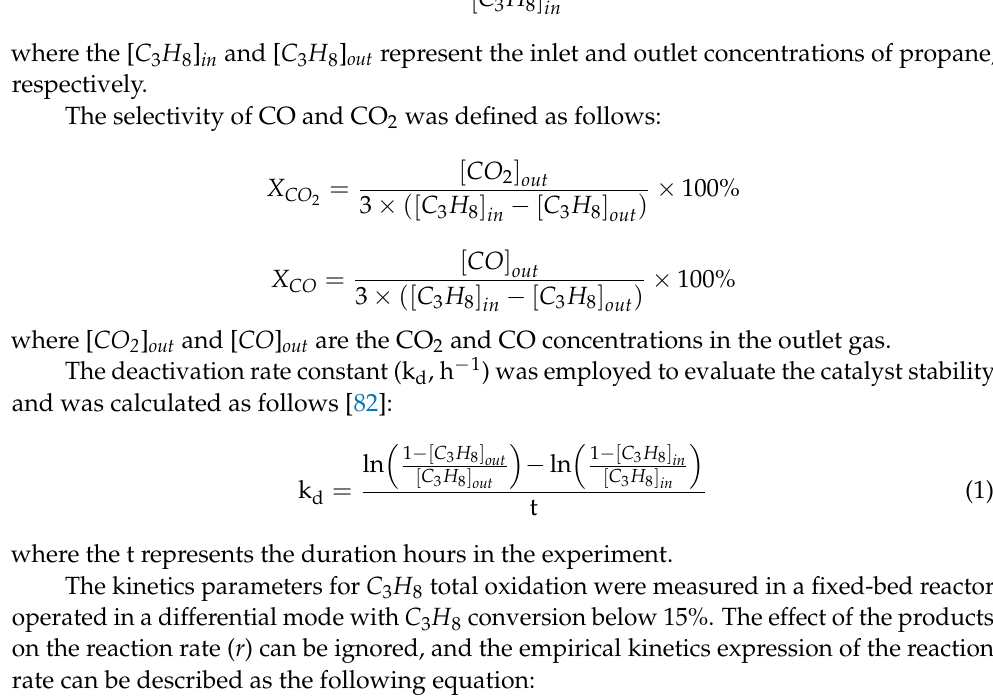
Figure S3: Potentiometric titration employing n-butylamine for the synthesized catalysts; Figure S4: Thermal stability for propane oxidation catalyzed Ce 0.05 La 0.95 BO 3 , LaBO 3 , Cu/Ce 0.05 La 0.95 BO 3 , V/Ce 0.05 La 0.95 BO 3 , Co/Ce 0.05 La 0.95 BO 3 , and Ni/Ce 0.05 La 0.95 BO 3 ; Figure S5: The propane conversion and selectivity of CO 2 and CO catalyzed Cu/Ce 0.05 La 0.95 BO 3 ; Table S1: Potentiometric titration employing n-butylamine test results of the synthesized